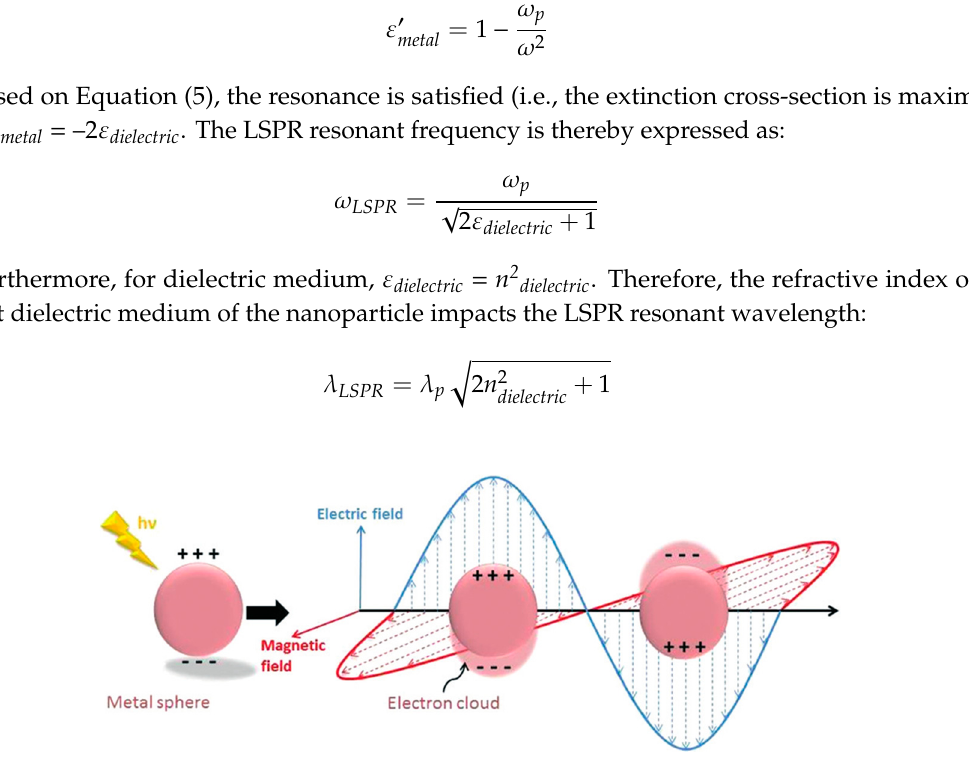
Figure 10. The schematic diagram of localized surface plasmon resonance (Figure adapted with permission from Ref. [81]).